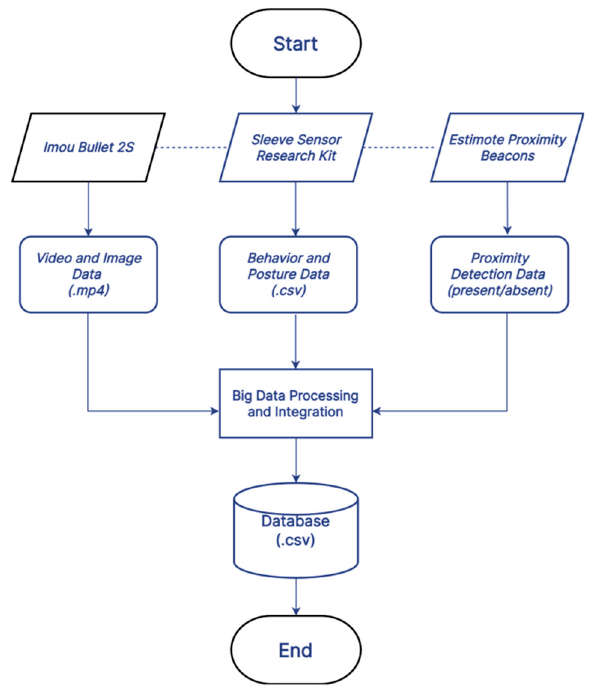
Figure 1. Flowchart illustrating the working of the proposed system .